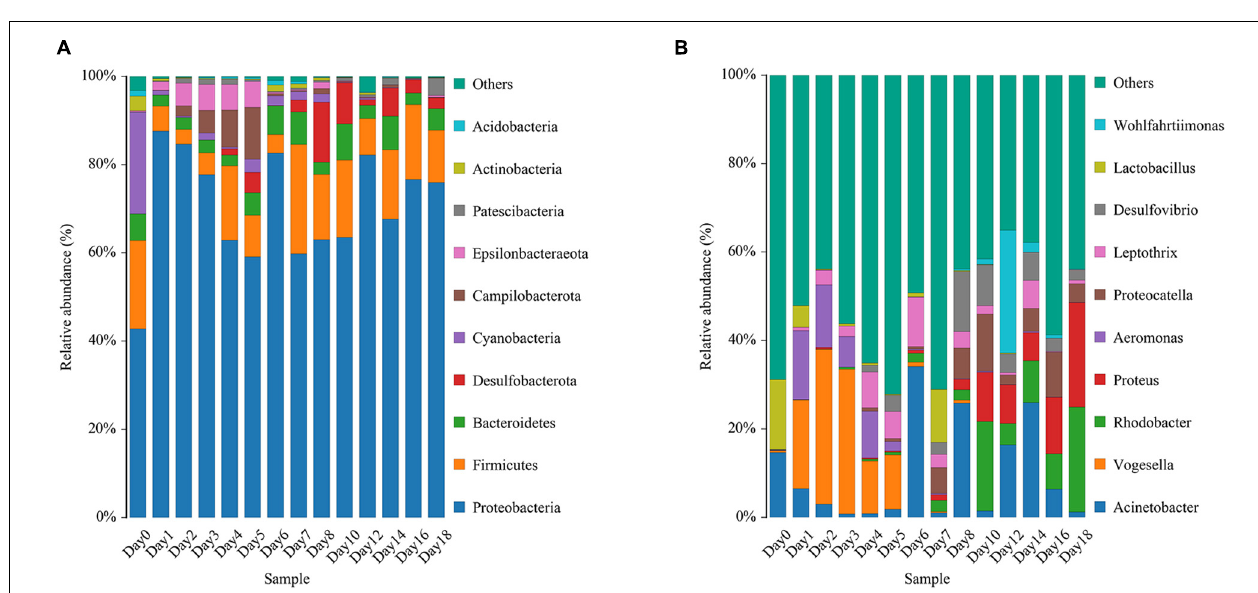
FIGURE 3 | The number of changes of different classification units (family, genus, and species) with time during decomposition.